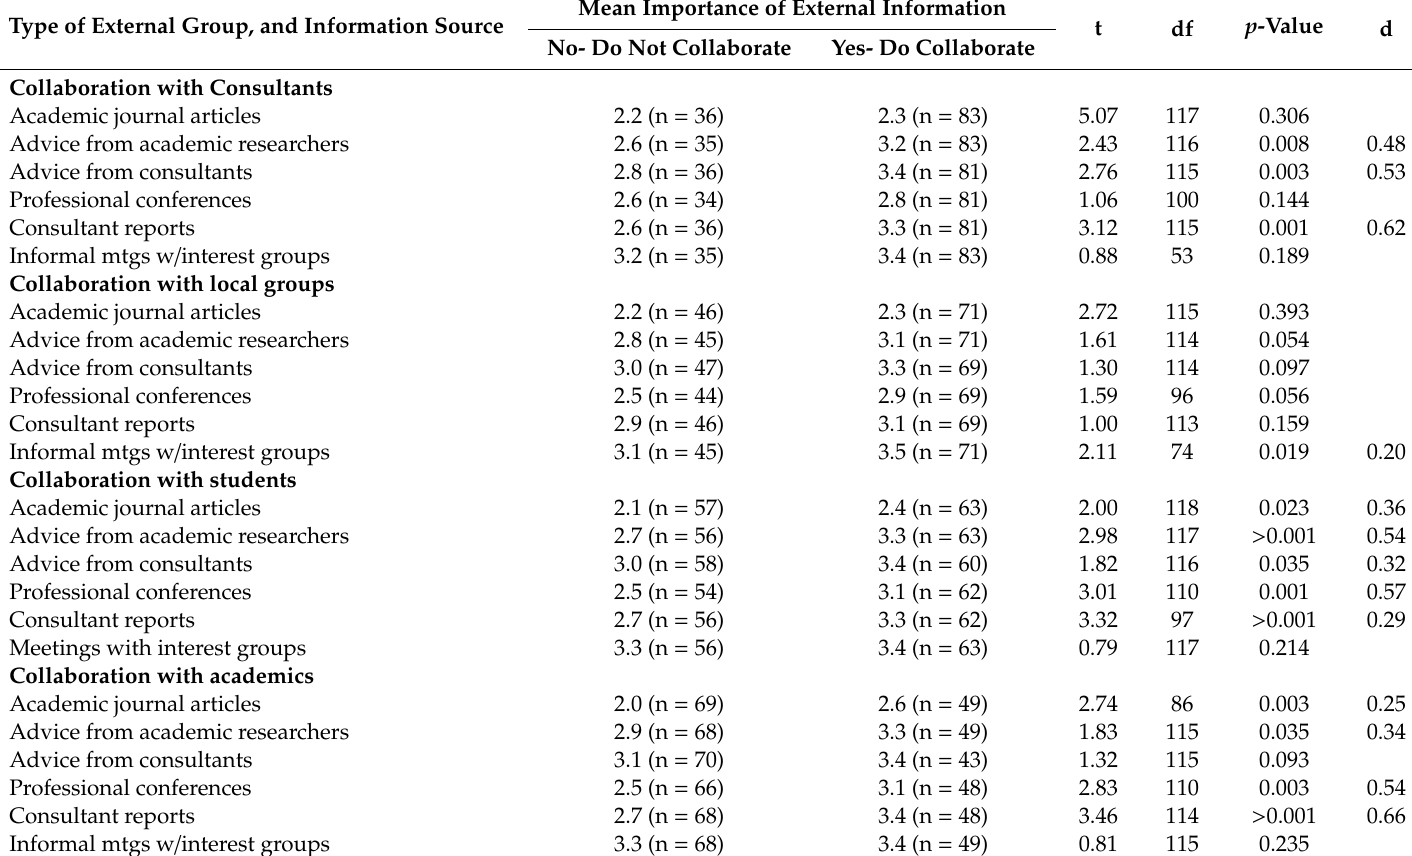
Table 3. The e ff ect of collaboration (yes, no) with external groups on the perceived importance of external information. Type of External Group, and Information